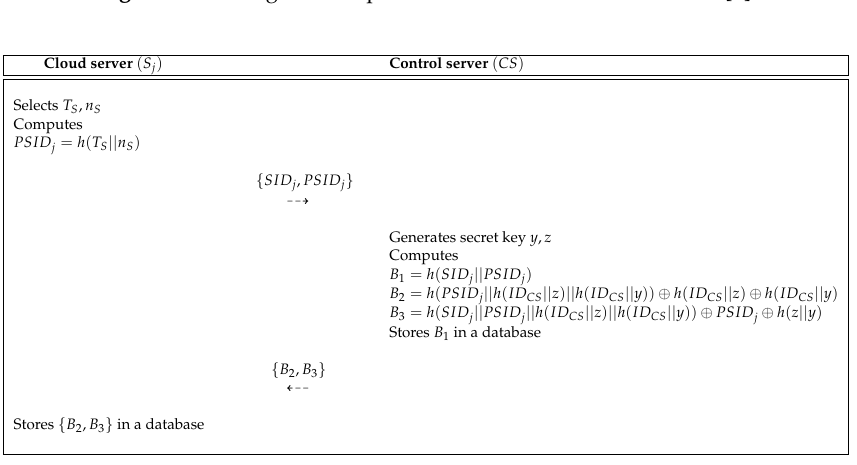
Figure 1. User registration process of the Pelaez et al.’s scheme [8].